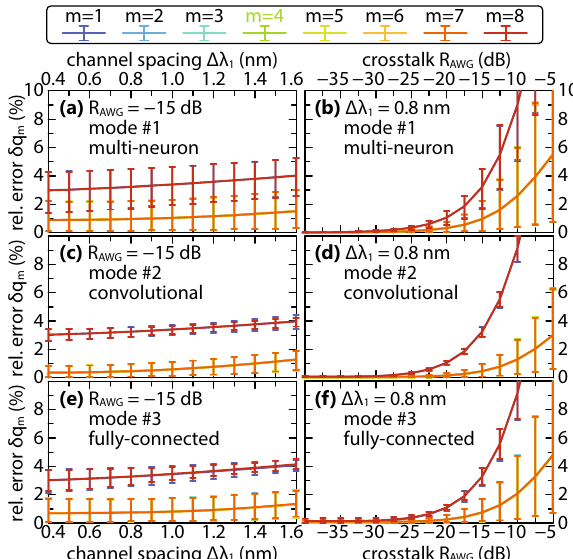
Figure 5. Mean relative errors of the matrix element δ q m (given in percent) with 5% to 95% confidence bounds for ( a ), ( b ) multi-neuron, ( c ), ( d ) convolutional, and ( e ), ( f ) FC mode of operation, depending on ( a ), ( c ), ( e ) 15dB and ( b ), ( d ), ( f ) AWG crosstalk for (cid:31) (cid:31) 1 channel spacing for R AWG = −